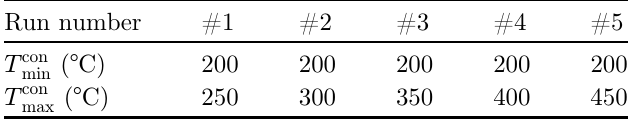
Fig. 8. Obtained temperature vs target one (run #1, run #3 and run #5) for the tested pro fi les (a) pro fi le #1 and (b) pro fi le #2. Table 1. Tested minimum and maximum values for the selected control temperature pro fi